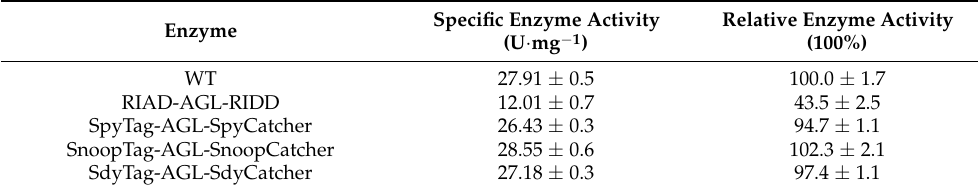
Table 1. Specific enzyme activities of wild-type and cyclized AGL.